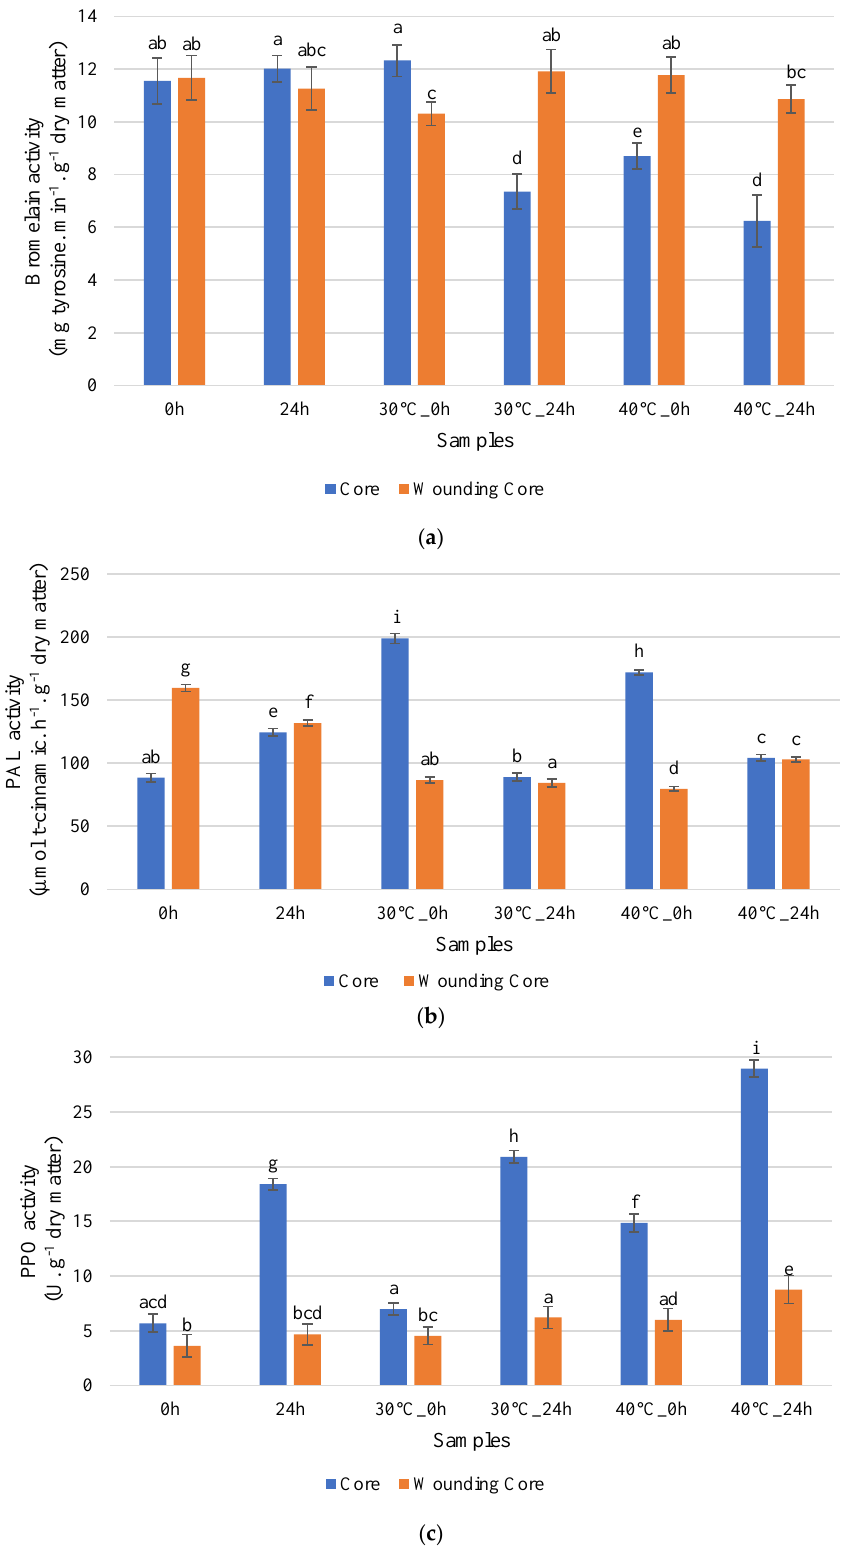
Figure 6. Effect of abiotic stresses, heat treatment and wounding, on the enzymatic activity of pineapple core: ( a ) bromelain activity; ( b ) phenylalanine ammonia-lyase activity (PAL); and ( c ) polyphenol oxidase activity (PPO). Error bars stand for ± standard deviation (n = 9). Different letters express significant differences between